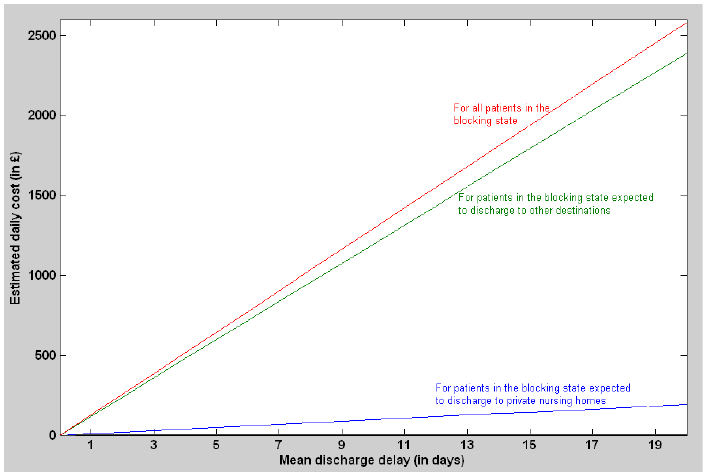
Figure 10. The estimated daily cost of care for patients in the blocking state expected to be discharged to each destination (after 1000 days since the first patient gets delayed).